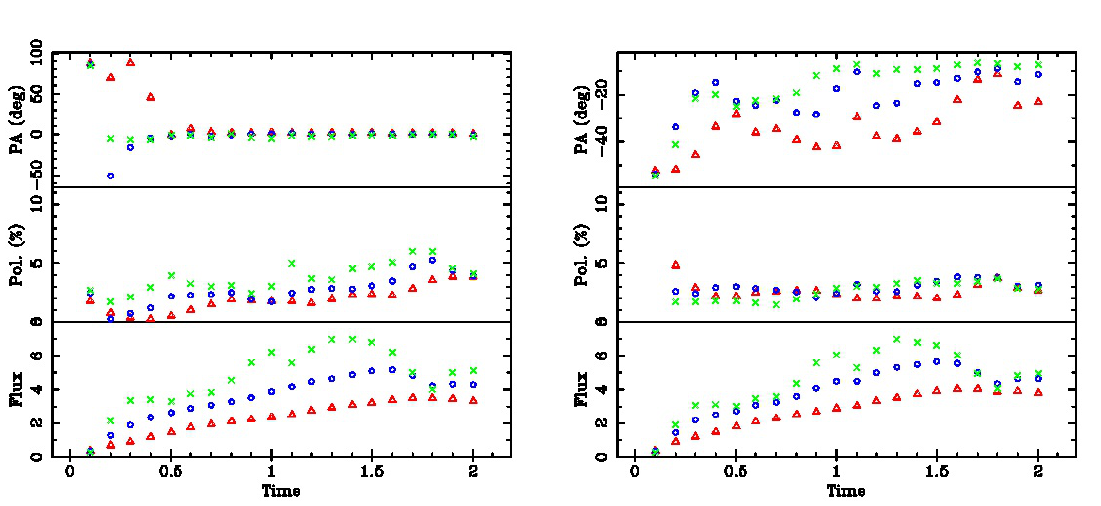
Figure 5. ( Left ): The simulated light curves for the 1985.0 outburst based on the adopted parameters; ( Right ): The simulated light curves assuming the inclusion of an additional strong helical B field and the adopted values for all other